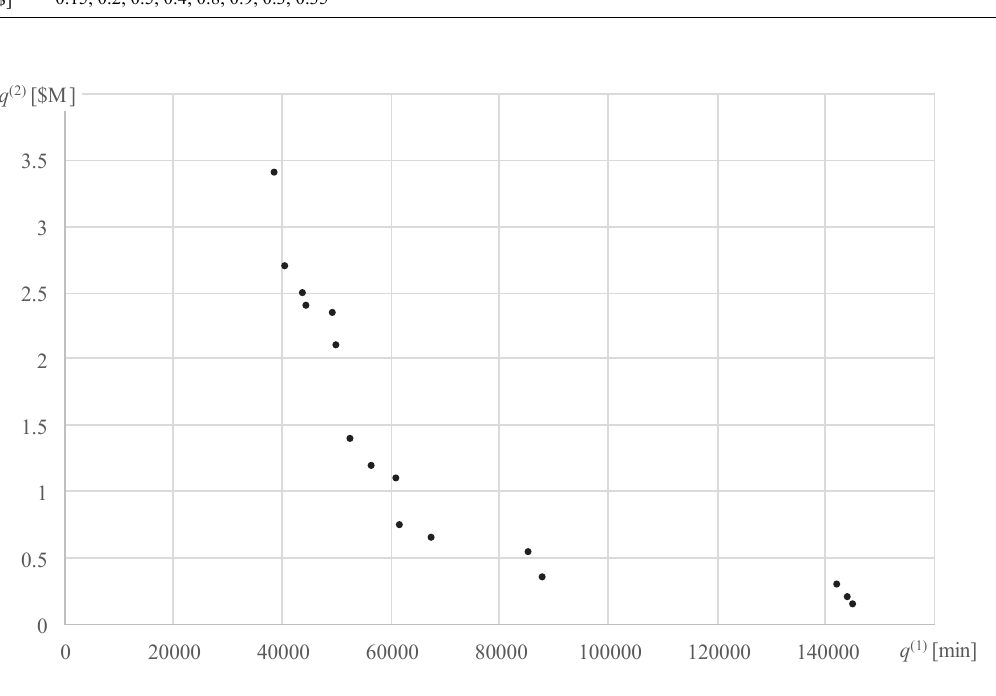
Fig. 7. The obtained Pareto front